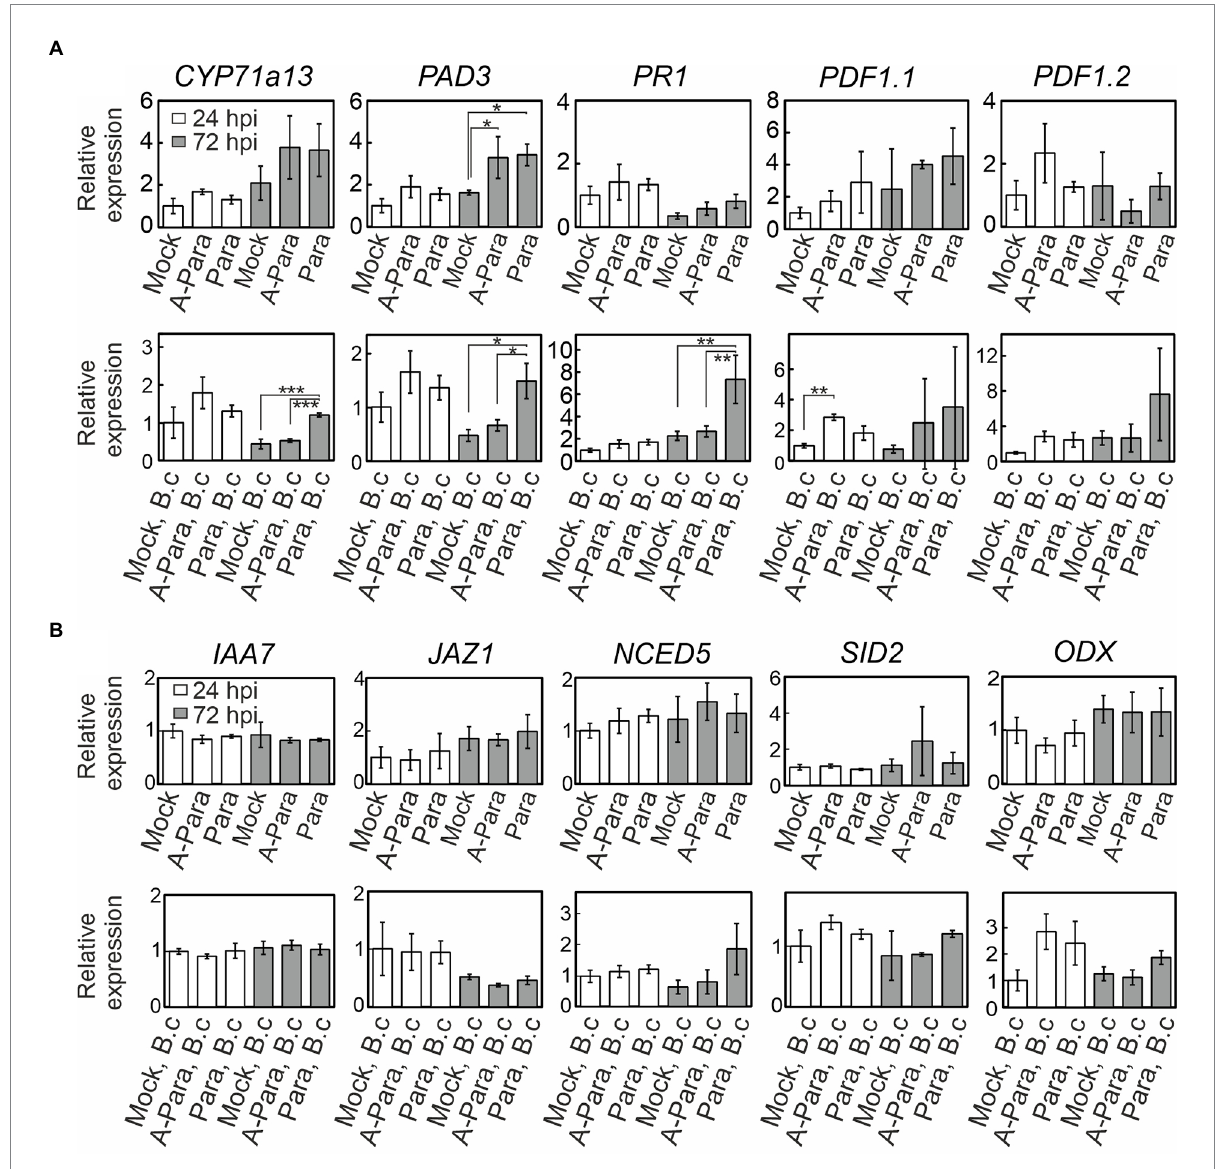
FIGURE 6 Plant defense and hormone signaling marker expression. Relative gene expression of plant defense and hormone signaling genes at 24 (white bar) and 72 (grey bar) hours post infection (hpi) following P. arabidopsidicola strain C29 treatment only (top row), and with Botrytis infections following strain C29 pre-treatments (bottom row). Relative expression is calculated to facilitate comparisons within but not between the top and bottom rows; i.e. top row is normalized to the 24 h control and the bottom row is normalized to the Botrytis -treated 24 h control. All time points are relative to the last treatment; relative to the strain C29 treatment in the top row and relative to the Botrytis treatment in the bottom row. (A) Expression of the genes: CYP71a13 , CYTOCHROME P450, FAMILY 71, SUBFAMILY A, POLYPEPTIDE 13, a marker for camalexin biosynthesis ; PAD3, PHYTOALEXIN DEFICIENT 3, a camalexin marker ; PR1, PATHOGENESIS-RELATED GENE 1, a late salicylic acid-response marker ; PDF1.1, PLANT DEFENSIN 1.1, a jasmonic acid-response marker ; PDF1.2 , PLANT DEFENSIN 1.2 , a jasmonic acid-response marker. (B) Expression of the genes: IAA7, INDOLE-3-ACETIC ACID 7 , an auxin-response marker; JAZ1, JASMONATE-ZIM-DOMAIN PROTEIN1 , an early jasmonic acid-response marker; NCED5, NINE-CIS-EPOXYCAROTENOID DIOXYGENASE 5 , an ABA-response marker; SID2, SALICYLIC ACID INDUCTION DEFICIENT 2 , a salicylic acid-response marker; ODX, 2-OXOACID-DEPENDENT DIOXYGENASE , a salicylic acid-response marker. Data are presented as mean relative expression levels ± SD of three pooled biological repeats. Statistics was performed with glht package in R (v3.5.1) with fdr method for adjusted p values. Para: P. arabidopsidicola strain C29; A-Para: autoclaved P. arabidopsidicola strain C29; B.c: Botrytis cinerea infected. * p < 0.05; ** p < 0.01; *** p <